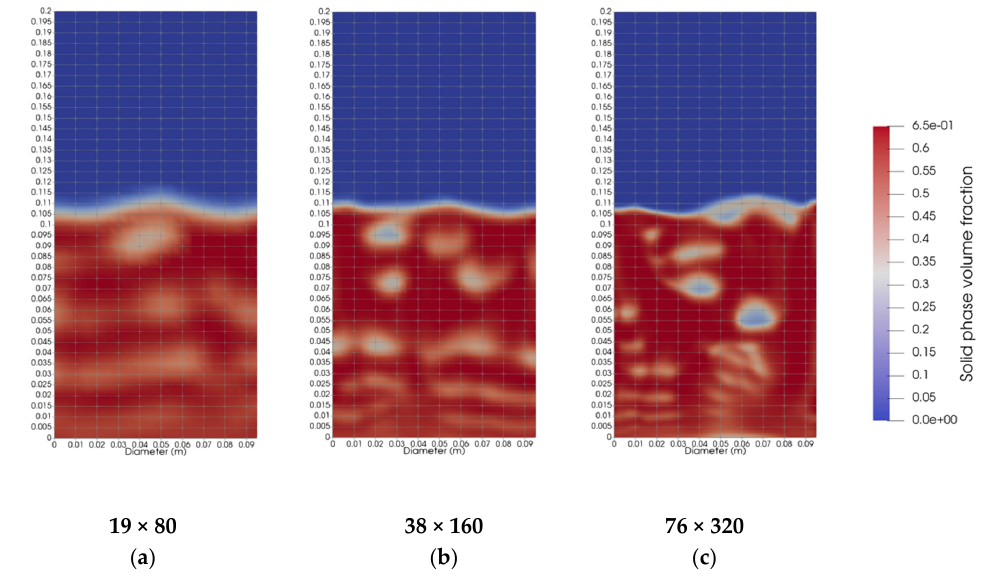
Figure 5. Instantaneous solid phase volume fraction at time t = 20 s: images are referred to calculations carried out by using Fluent code implementing user defined function (UDF) considering three different grid refinement: ( a ) 19 × 80; ( b ) 38 × 160; ( c ) 76 × 320.